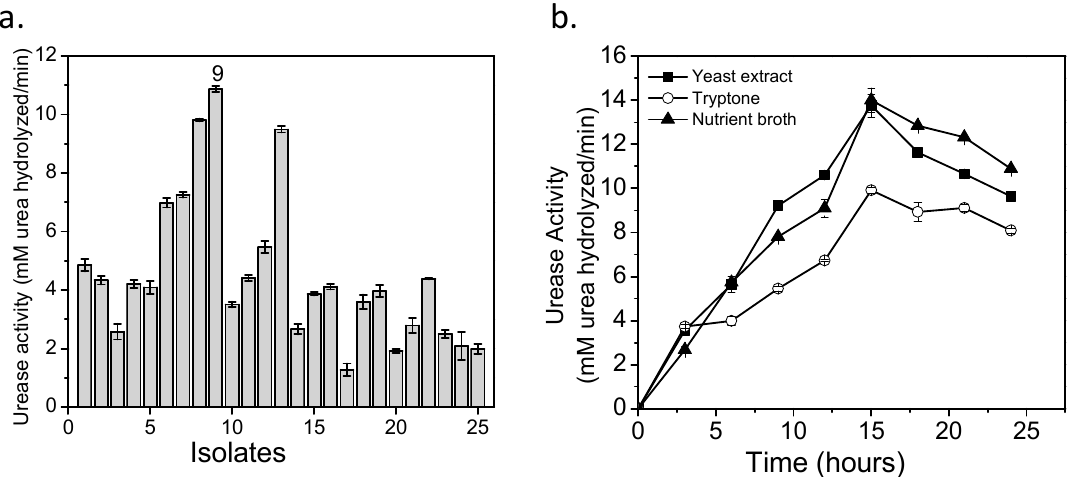
Figure 1. ( a ) Ureolytic bacteria isolated from different soils of Boyacá. ( b ) Effect of growth media on urease activity of S. pasteurii.